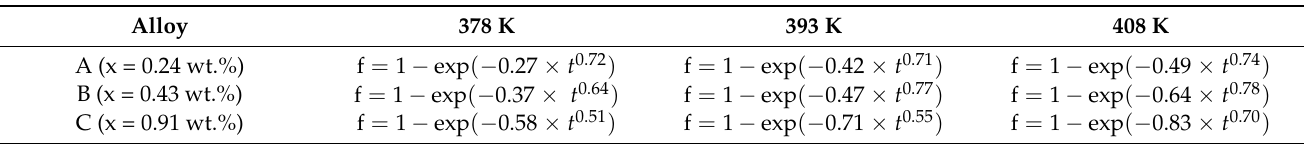
Table 4. Precipitation kinetics equations of different Al-5Zn-2.6Mg-xCu alloys and temperatures of aging treatment.